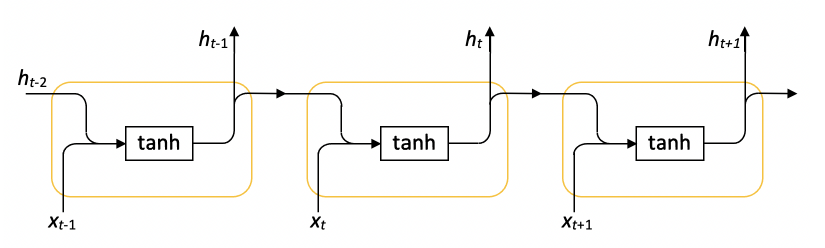
Figure 1. An illustration of an RNN